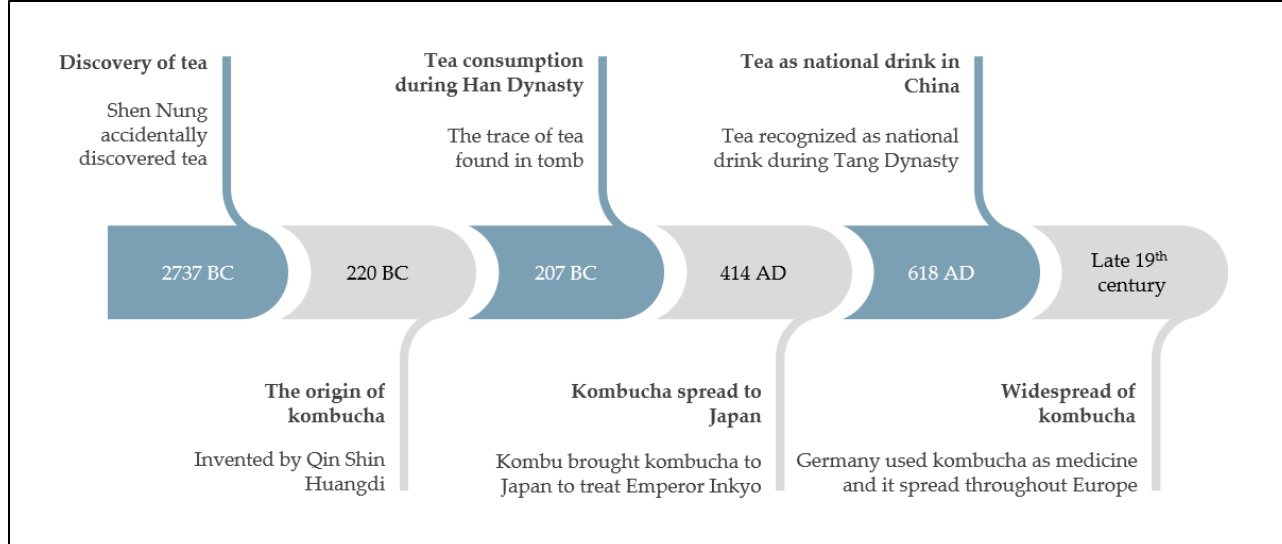
Figure 3. A brief timeline of tea and kombucha history.